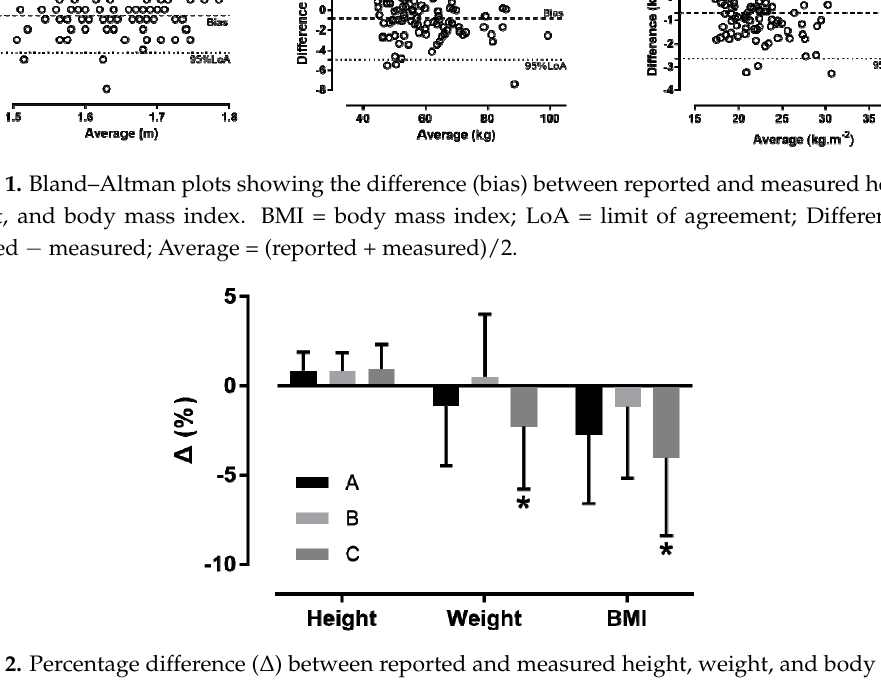
Figure 2. Percentage difference ( ∆ ) between reported and measured height, weight, and body mass index at 12–2 p.m. (group A, n = 36), 2–4 p.m. (group B, n = 20), and 4–6 p.m. (group C, n = 37). BMI = body mass index; * different from group B at p < 0.001. A medium effect of % Δ BMI on MET × min was observed ( p = 0.086, η 2 = 0.127) with Q3 being the most physically active and Q4 the least (Table 1). A quartile × time of day association is shown ( χ 2 = 11.38, p = 0.077, φ = 0.35), where at 12–2 p.m. most participants were classified in Q3, at 2–4 p.m. most were in Q4, and at 4–6 p.m. most were in Q1 and Q2. A quartile × menstrual cycle phase association was also found ( χ 2 = 8.31, p = 0.040, φ = 0.60), where most of Q1 and Q2 were at the mid-luteal phase, and most of Q3 and Q4 at the early follicular phase. Table 1. Scores of quartile groups based on % Δ BMI.